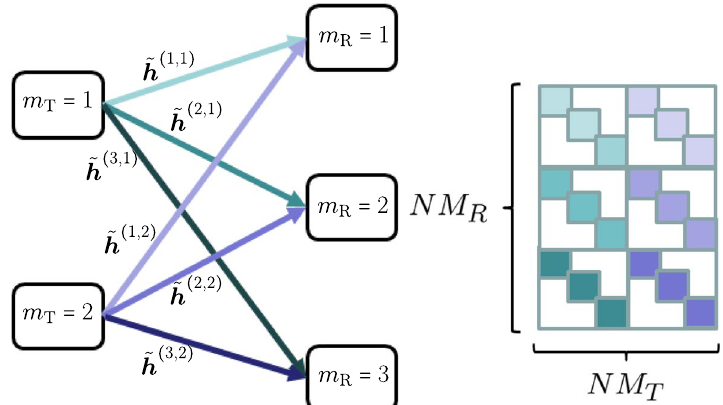
Fig. 2 A MIMO system with M T = 2 transmit antennas and M R = 3 receive antennas (left-hand side). Visualization of the generalized unfolding [ ˜ H ] ( [ 1,3 ] , [ 2,4 ] ) for the MIMO-OFDM (right-hand